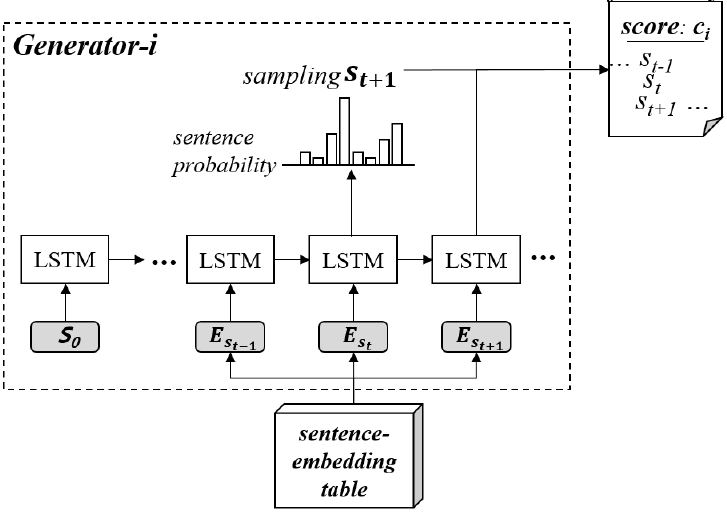
Figure 3. The architecture of the i -th generator in